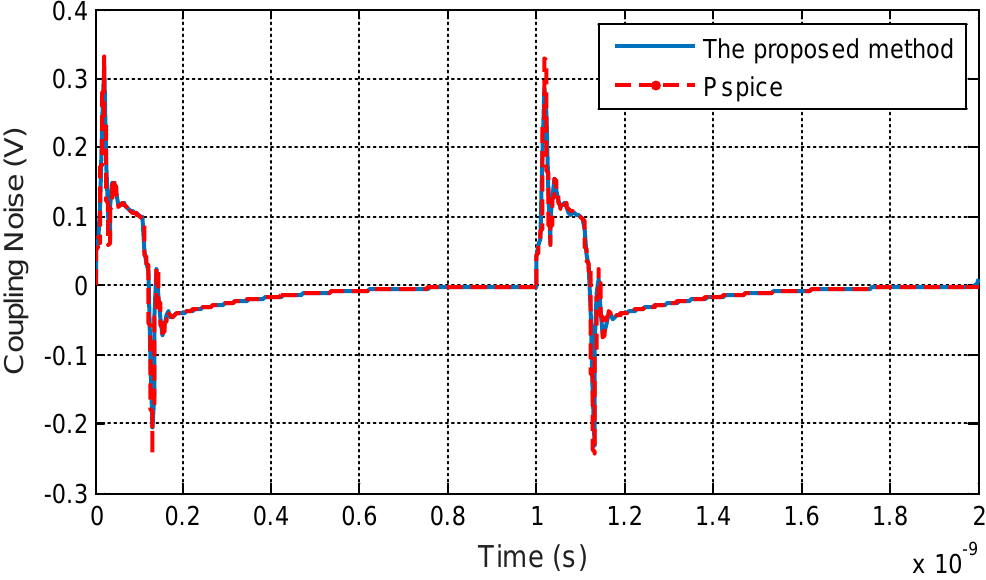
Figure 16. The proposed method and Pspice simulation of the TSV – TSV coupling noise with uncoupled RDLs ( l RDL = 500 µm) at port 3.